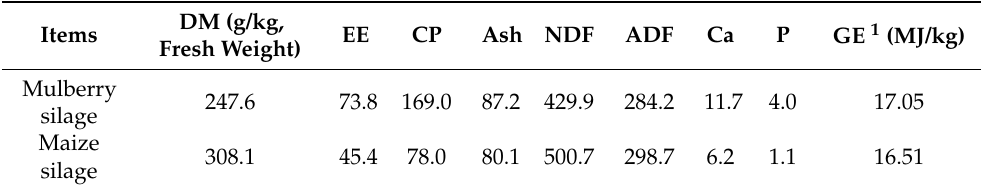
Table 2. Nutrient composition of mulberry silage and maize silage (g/kg DM, except where otherwise